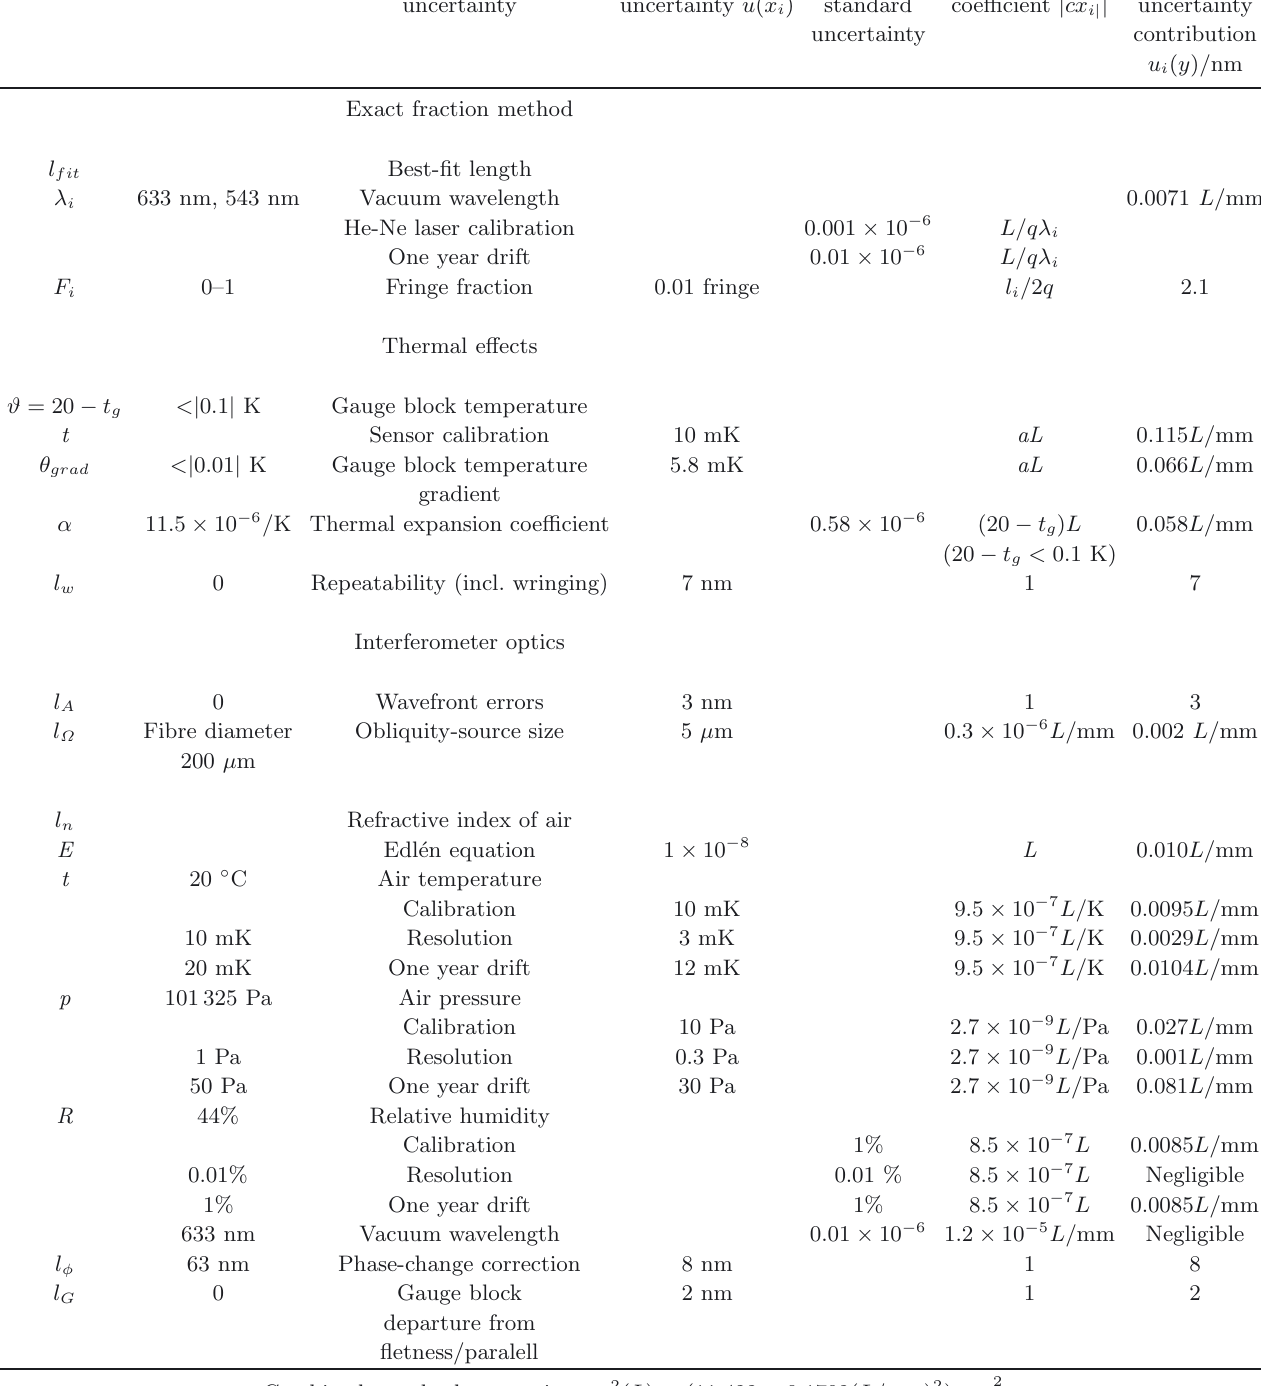
Combined standard uncertainty: u 2 ( L ) = (11 . 422 + 0 . 1702( L/ mm) 2 ) nm Linearized expanded uncertainty for coverage factor k = 2: U ( L ) = (23 + 0 . 18( L/ mm)) nm Calculation of standard uncertainty components for gauge blocks measurement by optical interferometry steel gauge blocks a = (11 . 5+/ − 1)